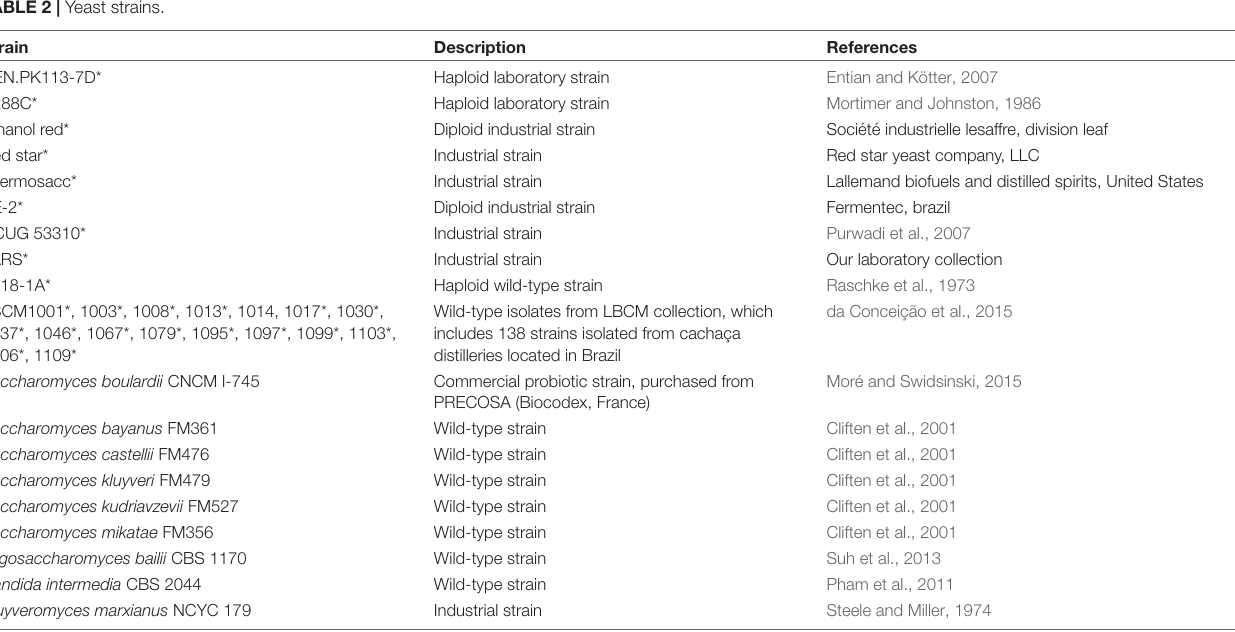
Table 2 ; Lee et al., 2015). The complete list of plasmids generated in this study is provided in Supplementary Table 3